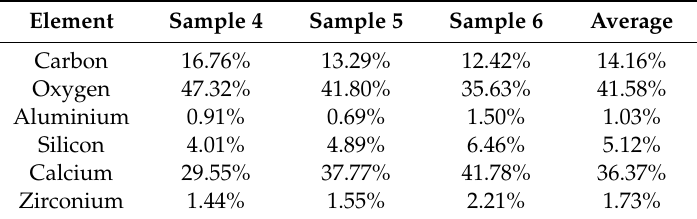
Table 2. Element analysis for the ProRoot MTA samples.